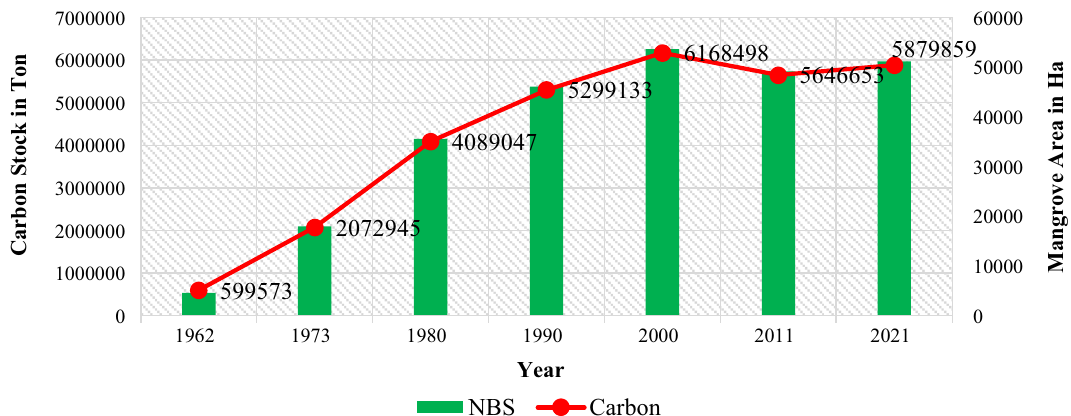
Fig. 13 Temporal carbon stock in the coast of Bangladesh due to the intervention of NBS by 60 years of afforestation and reforestation programs